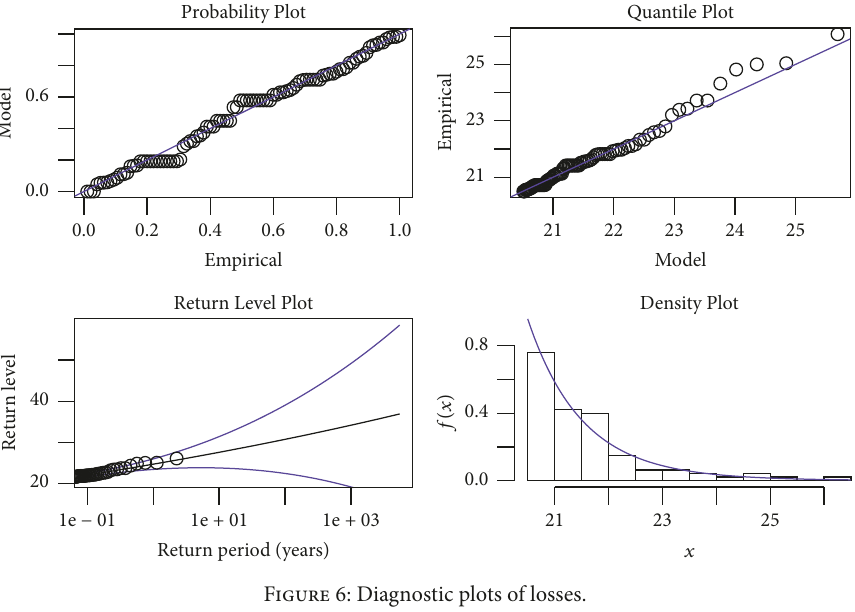
Figure 6: Diagnostic plots of losses.